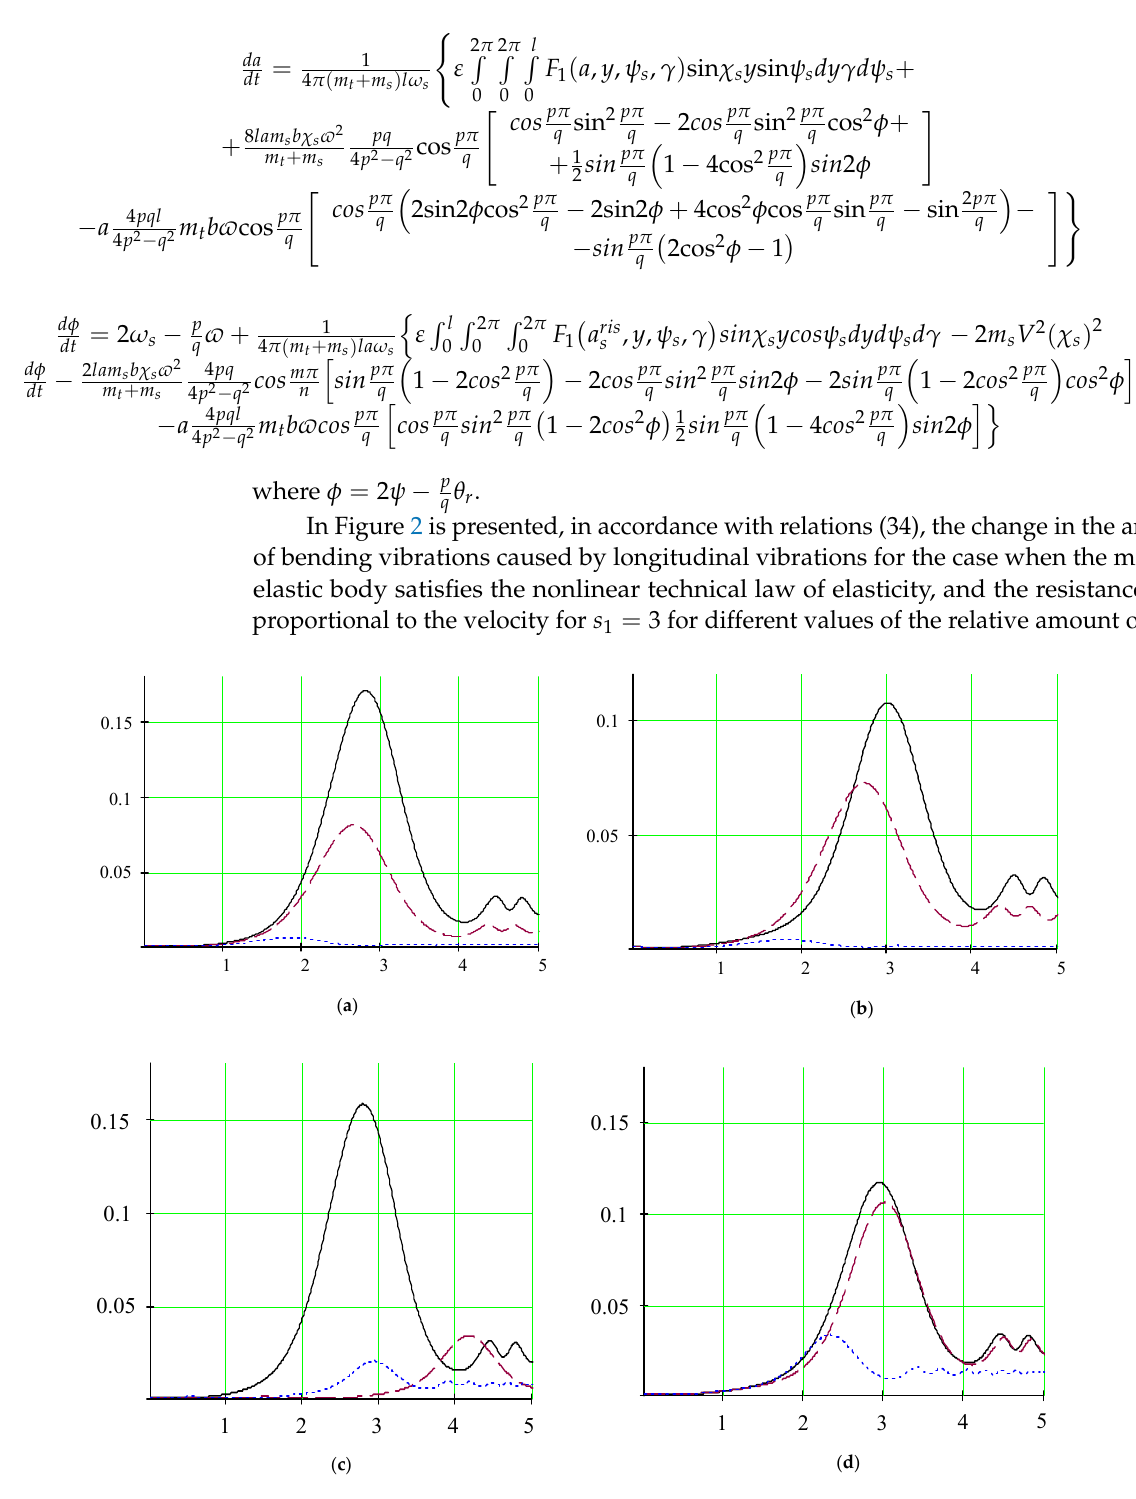
Figure 2. Laws of changes in the amplitude of bending vibrations during the transition through internal resonance at different values of the relative amount of motion CFHM ( k = m s V): ( a ) - - - - k = 200 kg m, —- —- —- k = 150 kg m, ——– k = 50 kg m, m t = 30; ( b ) - - - - k = 400 kg m, —- —- —- k = 300 kg m, ——– k = 100 kg m, m t = 30; ( c ) - - - - k = 400 kg m, —- —- —- k = 300 kg m, ——– k = 100 kg m, m t = 20; ( d ) - - - - k = 600 kg m, —- —- —- k = 450 kg m, ——– k = 10 kg m, m t =